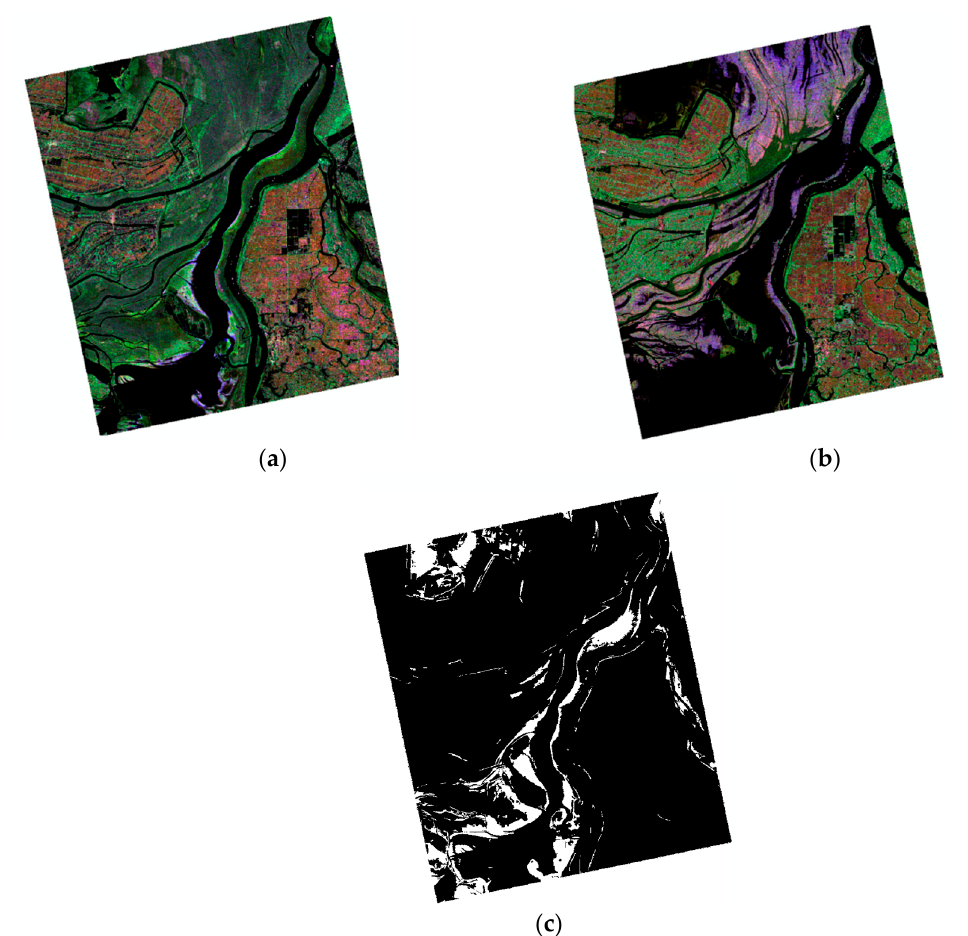
Figure 2. The color composite of the SAR images ( a ) before and ( b ) after the flooding event. Red, green, and blue channels correspond to the HH, HV, and VV intensity images, respectively. ( c ) The reference image.